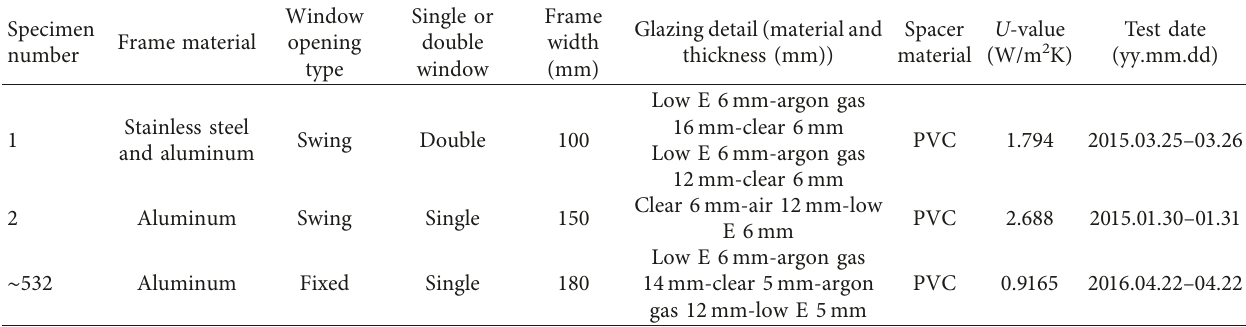
Table 1: Examples of U -value test results and window components.